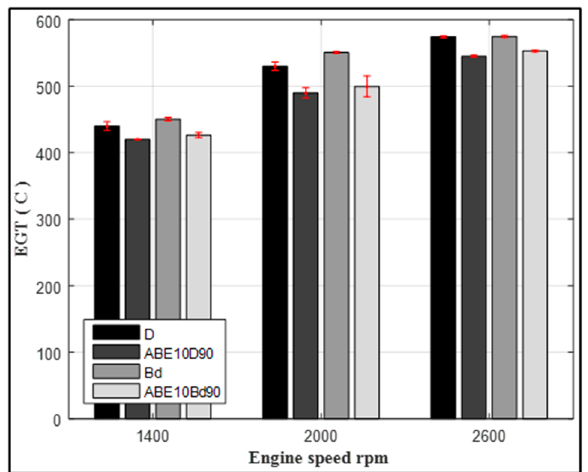
Figure 10. Exhaust gas temperature (EGT) of test fuels.